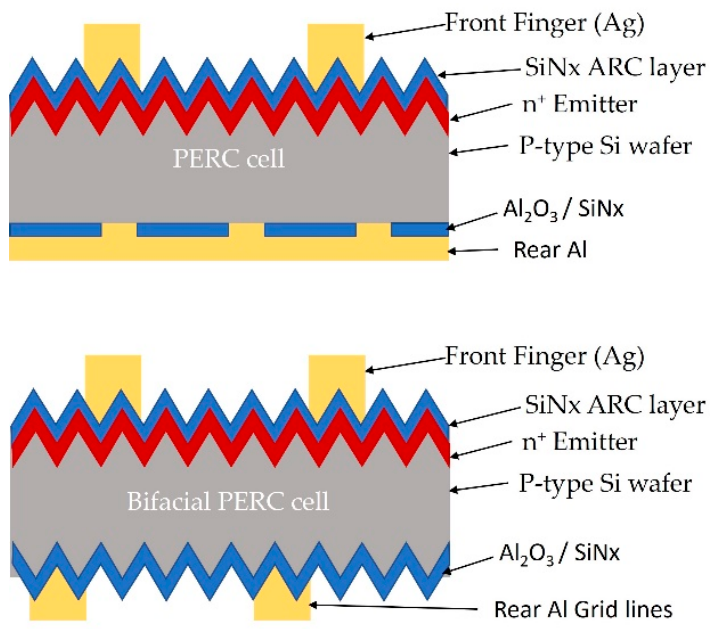
Figure 3. Simplified Schematic diagram of the PERC cell and Bifacial PERC.